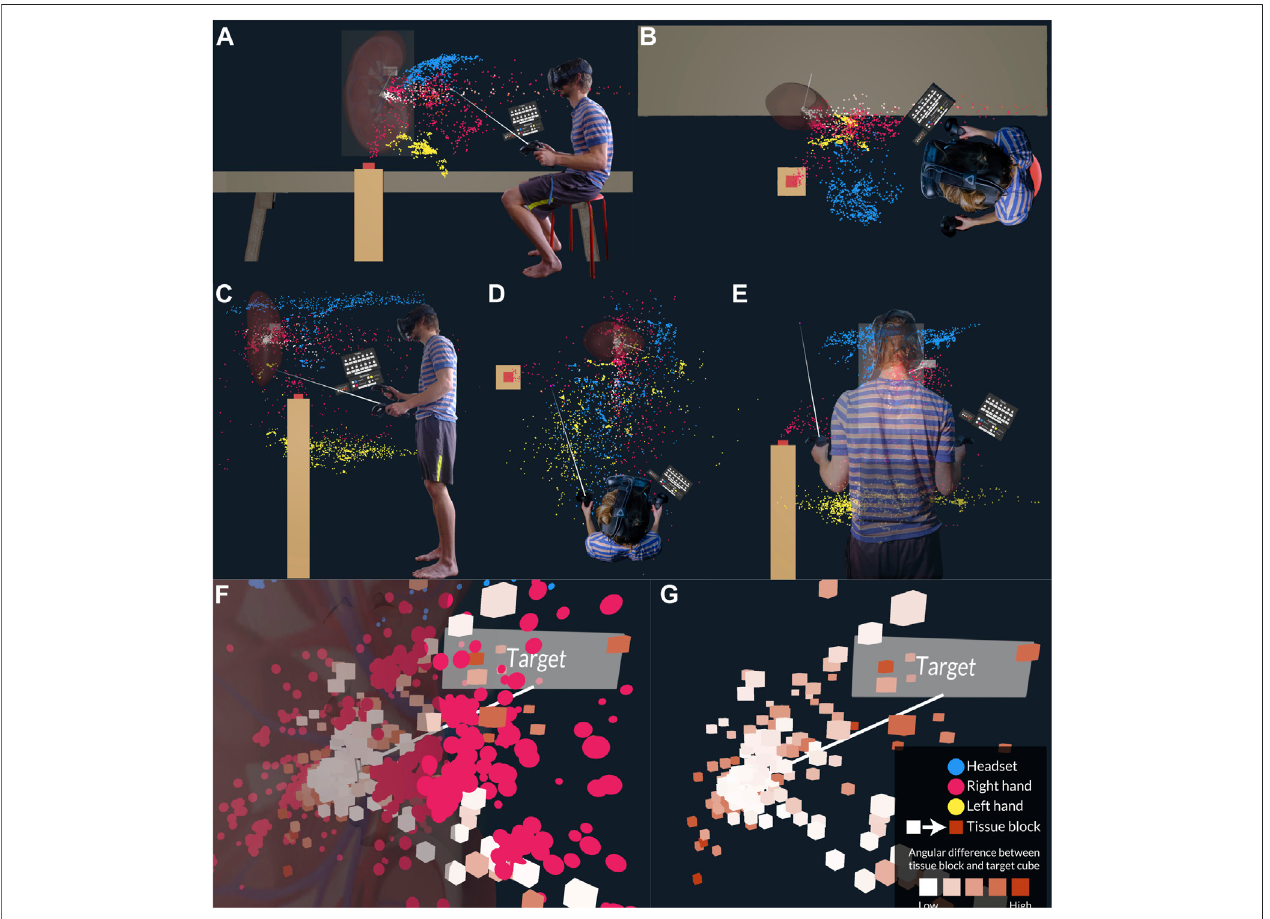
FIGURE2| Re fl ective phase setupforVRTabletopand VRStandup. (A) Sideview(VRTabletop). (B) Top view(VRTabletop). (C) Side view(VRStandup). (D) Top view(VRStandup). (E) Backview(VRStandup). (F) Closeviewoftissueblockpositionsovertimenearthetargetblockwithalldatavisible. (G) Sameviewwithoutkidney and data for right